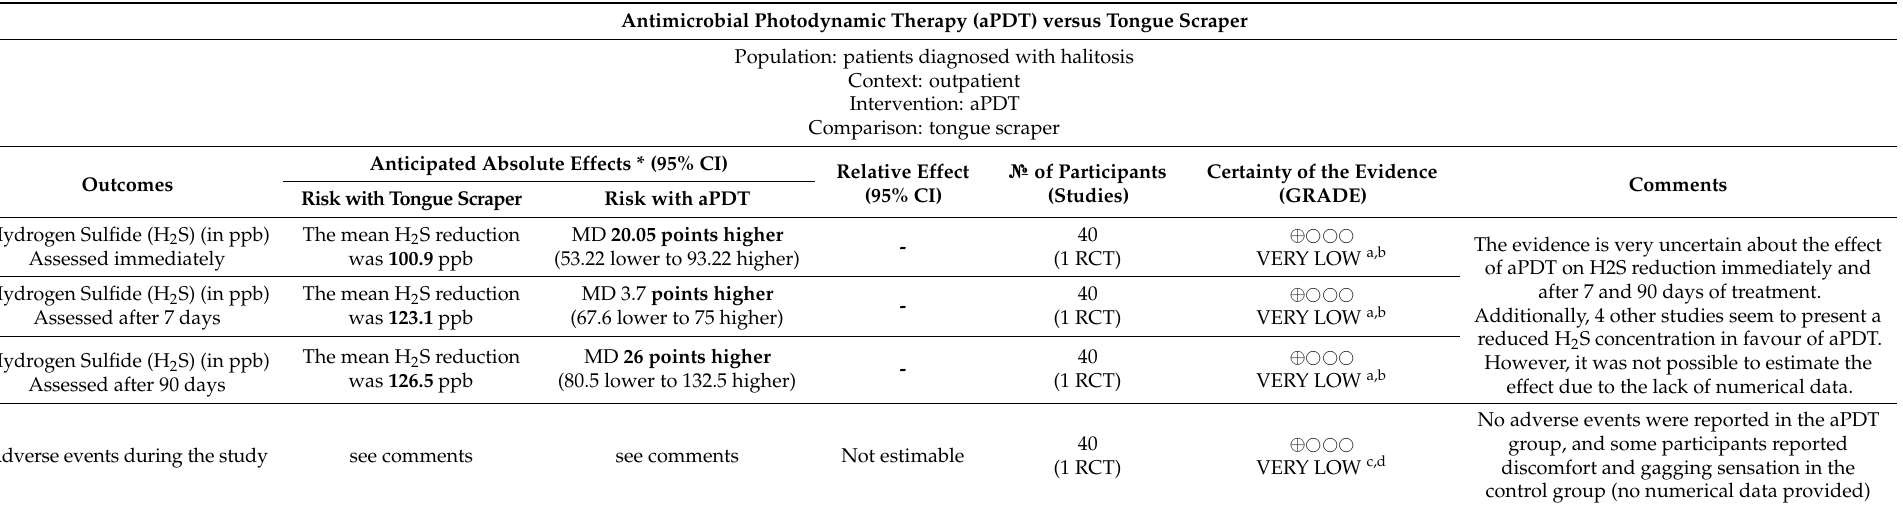
Table 3. Summary of findings—GRADE